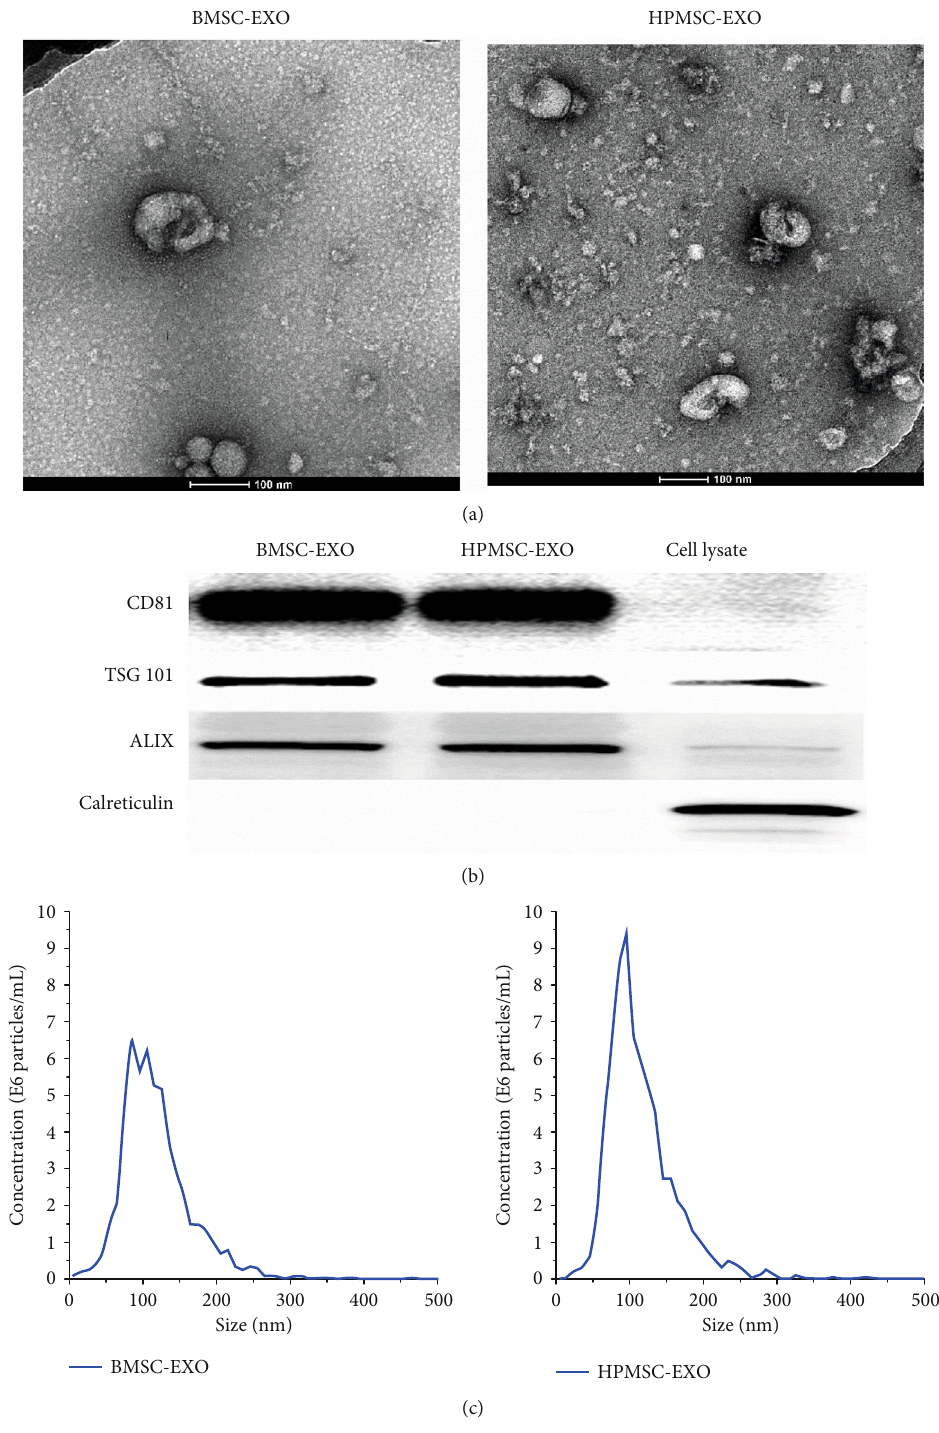
Figure 4: (a) Morphological characteristics of exosomes observed by TEM. (b) Marker protein expression of exosomes secreted from two types of MSCs detected by Western blot. (c) Exosomes characterized by